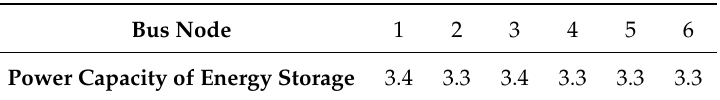
Table 5. Power capacity of energy storage in case 2 (MW).